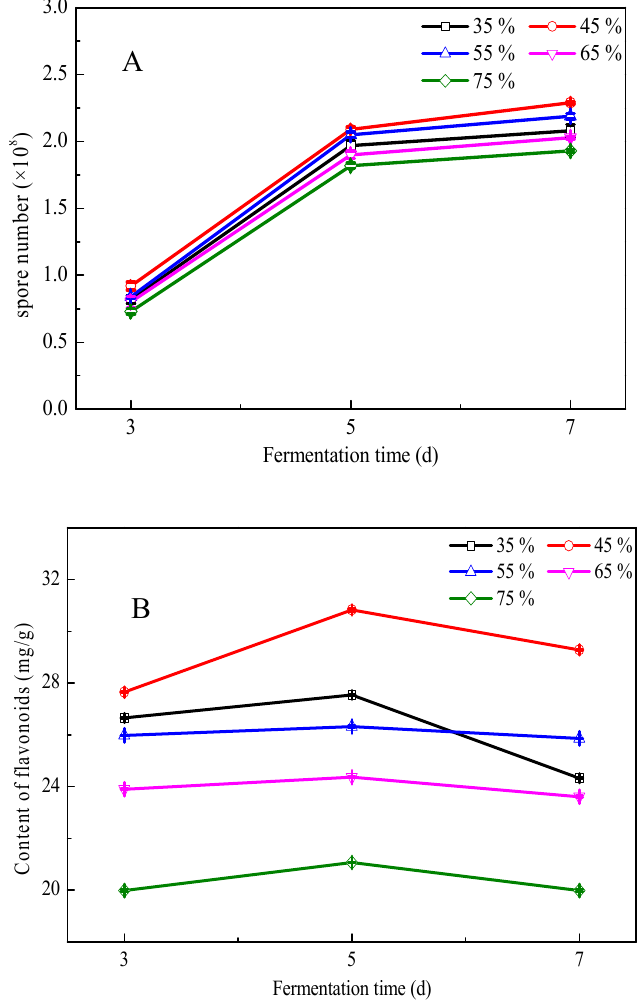
Figure5. Effectsofwatercontent(%, w / w )ondifferentindexes: ( A )sporenumberand( B Figure 5. Effects of water content (%, w/w ) on different indexes: ( A ) spore number and (B) flavonoid content.